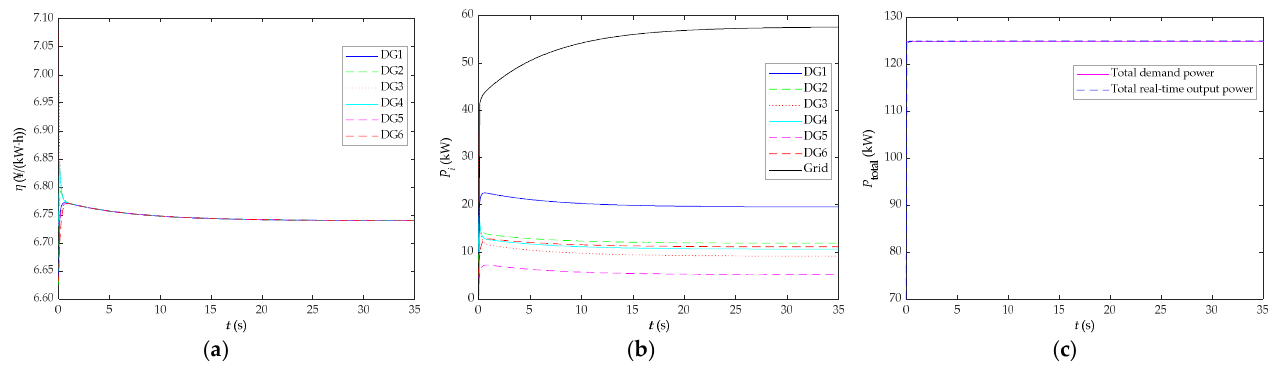
Figure 13. The change curves of variables of the system when ζ is set as 0.01: ( a ) change curves of each DG’s ICR; ( b ) change curves of each DG’s active output and grid output power; ( c ) change curves of the cumulative sum of each DG’s active output and grid output power as well as total demand power.